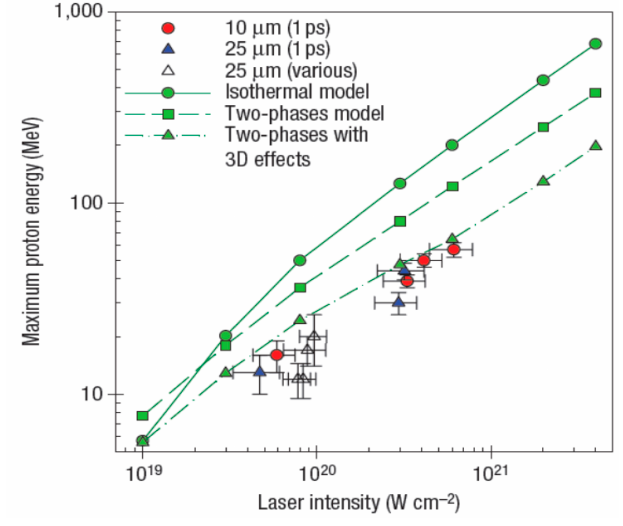
Figure 4. Maximum proton energy detected as a function of laser intensity obtained by variation of the laser pulse energy with a constant pulse duration of 1 ps for Al targets with thicknesses of 10 μm (red circles) and 25 μm (blue triangles). The open triang les correspond to laser shots on 25 μm targets for which the energy and pulse duration are both varied. The model data green curve is described in [33]. Reproduced from [33]. Copyright 2007, Macmillan